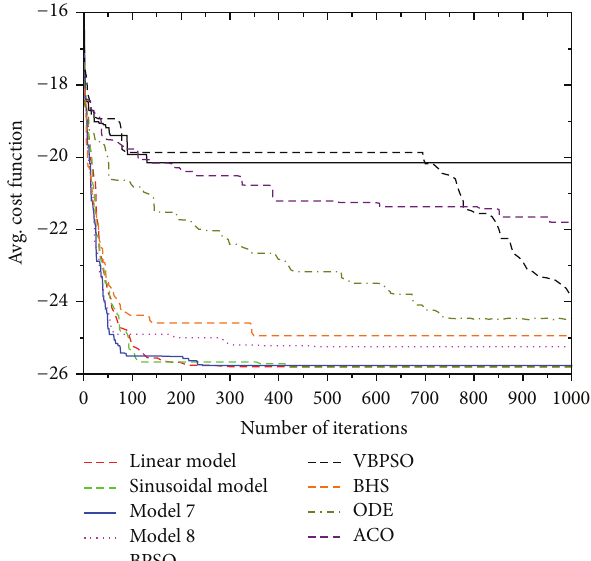
Figure 9: Convergence rate graph for the planar thinned array design case.